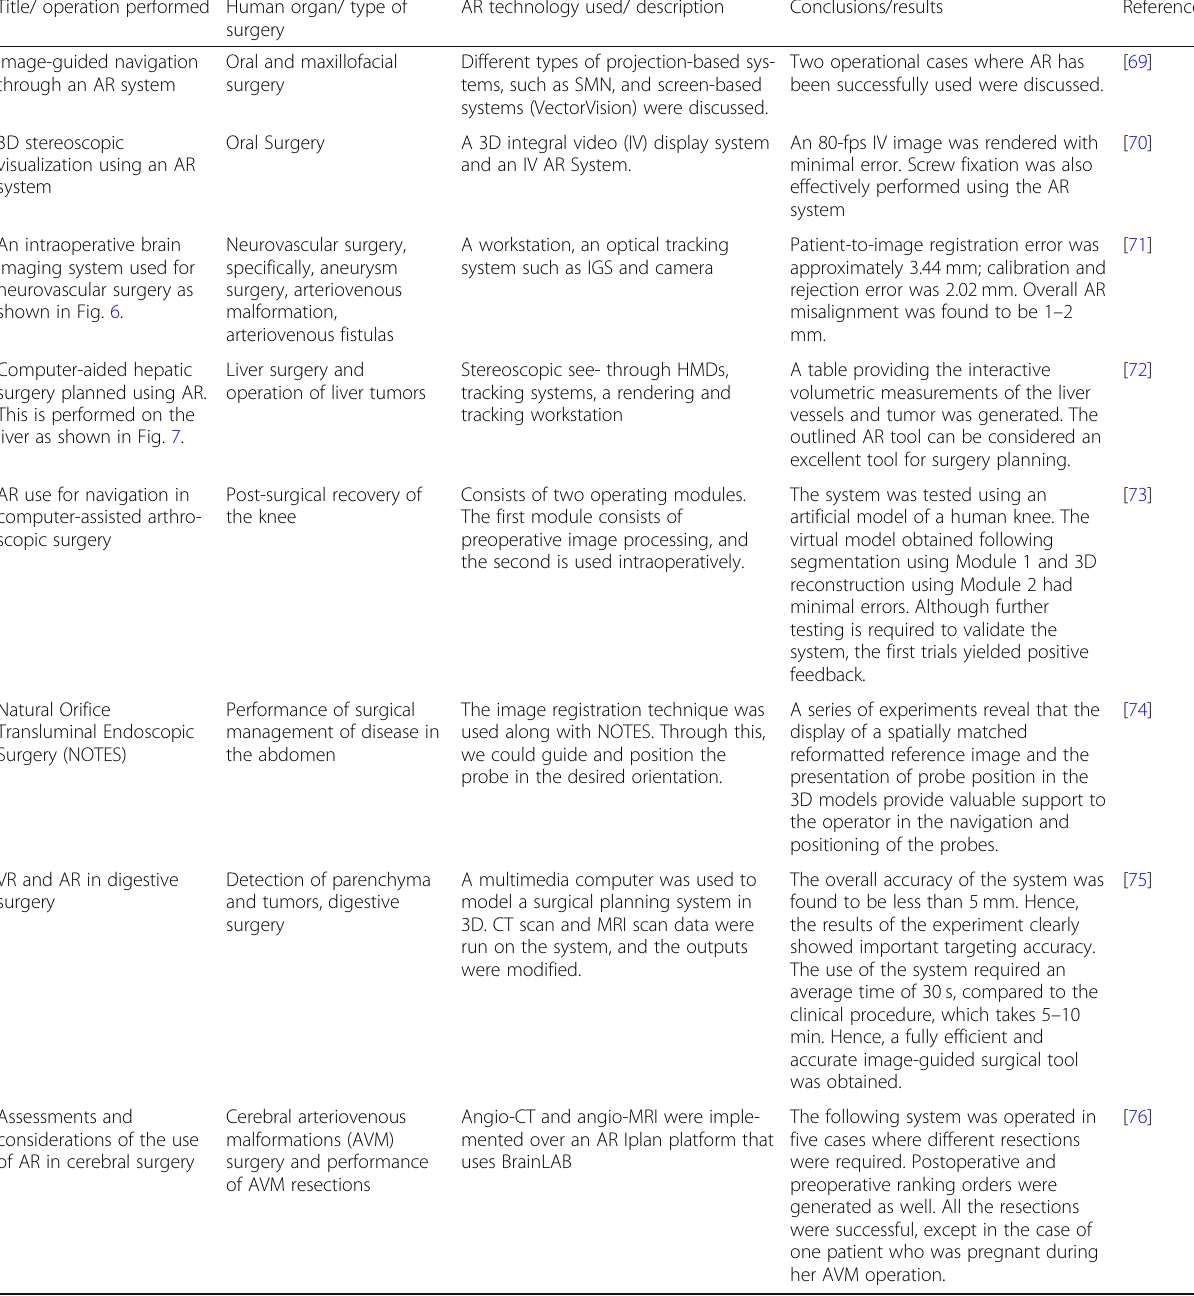
Title/ operation performed Human organ/ type of AR technology used/ surgery